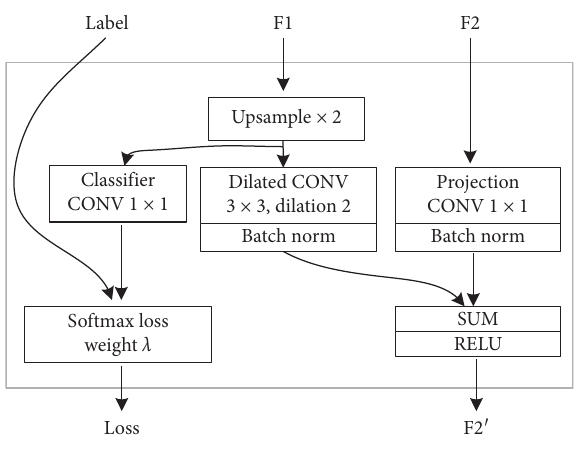
Figure 5: Cascade feature fusion